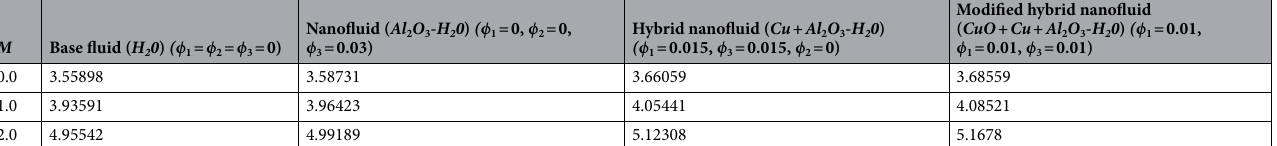
− k mnf θ ′ ( h ) for regular base fluid, ordinary nanofluid, hybrid nanoliquid and k f (cid:31) (cid:30)